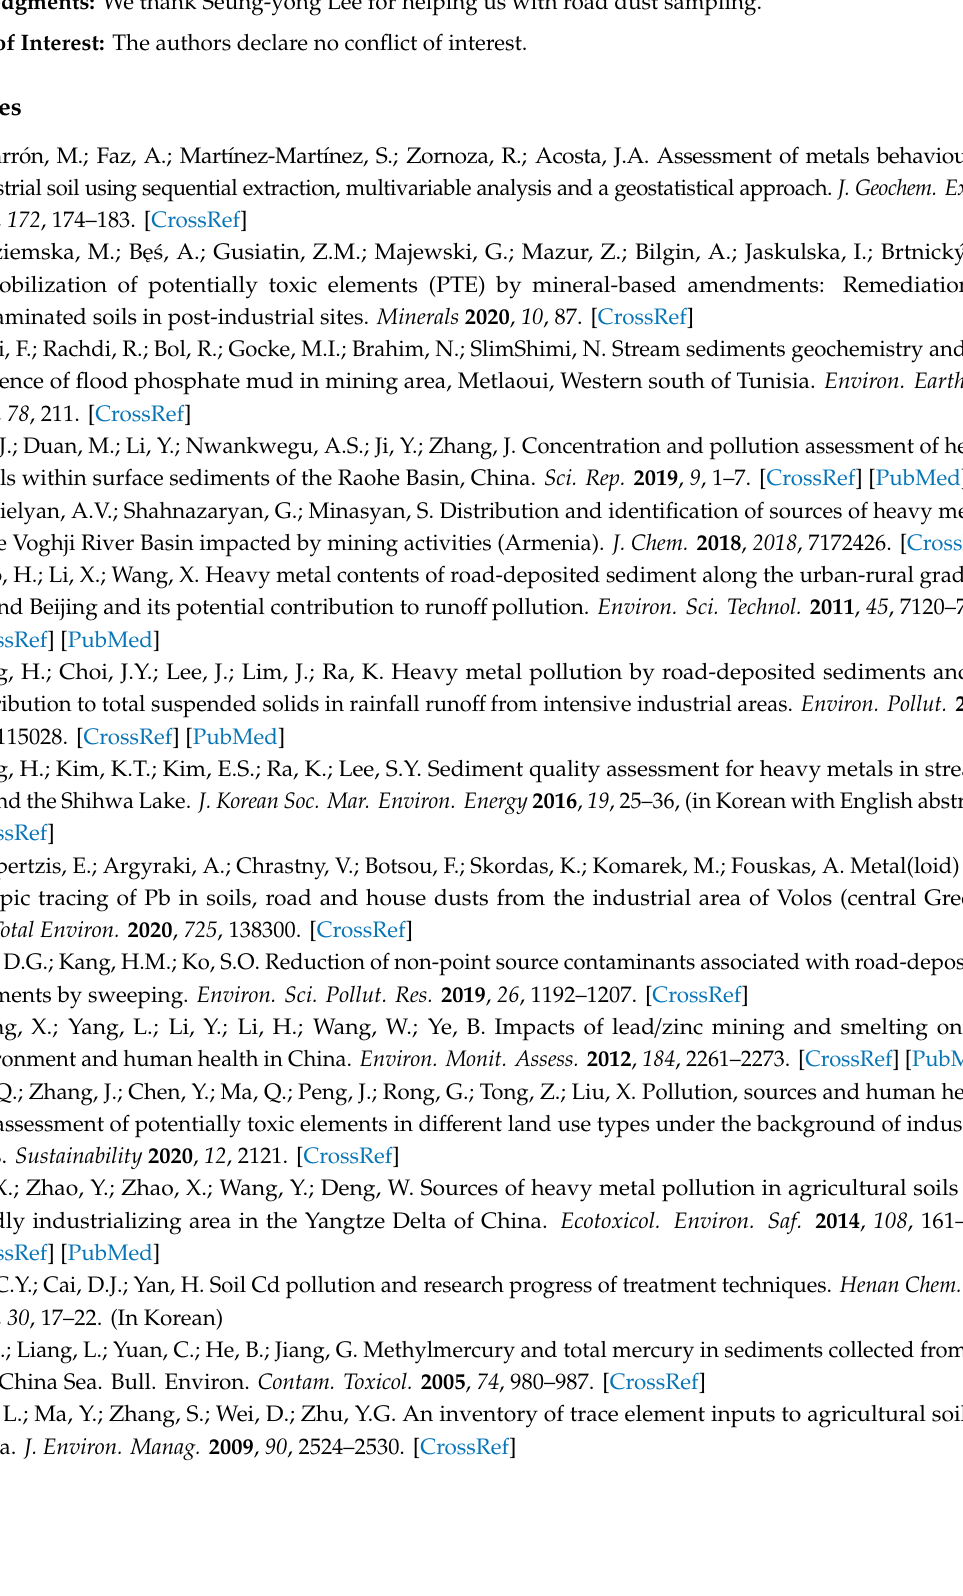
9 di ff erent Industrial regions of this study, Table S3: Pearson’s correlation coe ffi cient between the measured parameters in the RD of this study. Marked correlations (bold) are significant at the 0.01 level